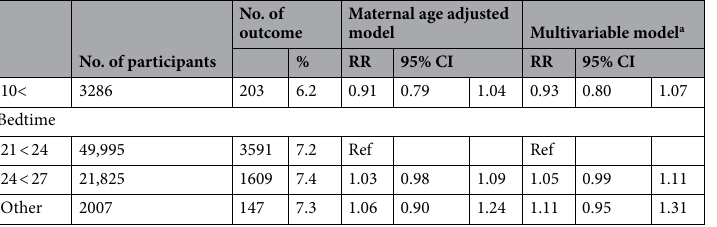
Table 2. Association between sleep before pregnancy and infant sleep, Japan Environment and Children’s Study (2011–2014). CI confidence interval, RR risk ratio. Bold fonts showed the items of infant’s sleep outcomes. a Adjusted for maternal age at delivery, smoking habits, alcohol consumption, pre-pregnancy body mass index, gestational age at birth, parity, infertility treatment, and infant